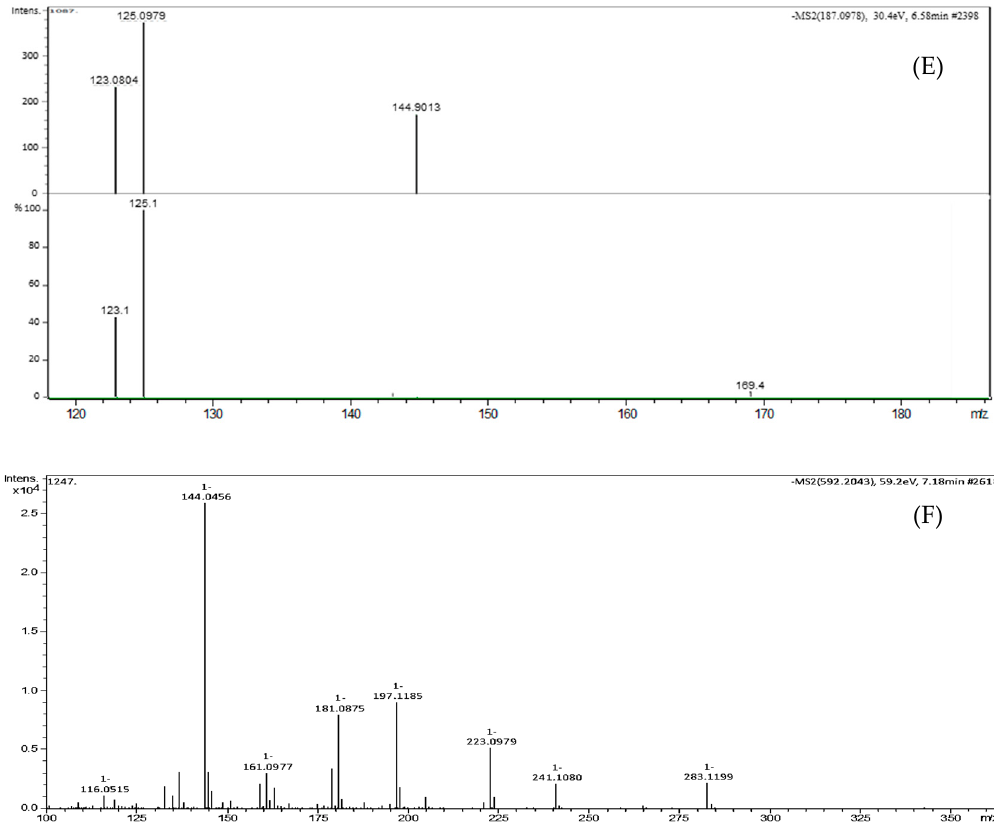
Figure 5. Head-to-tail spectral comparisons between the experimental MS/MS spectra and the referenced library MS/MS spectra. ( A ) Peak 1: Isoquercitrin, ( B ) peak 2: a catechin derivative; ( C ) peak 3: eriodictyol-7- O -glucoside, ( D ) peak 4: quercitrin, ( E ) peak 5: azelaic acid, ( F ) peak 6: glansreginin